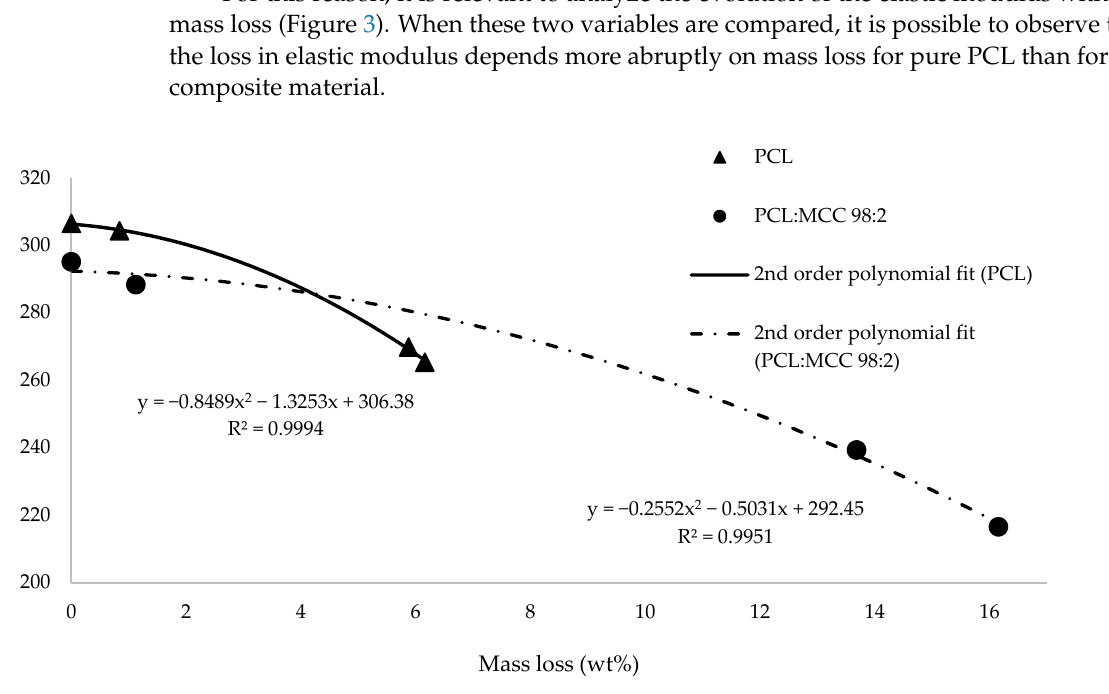
Figure 3. Evolution of the modulus of PCL and composite material with degradation time.